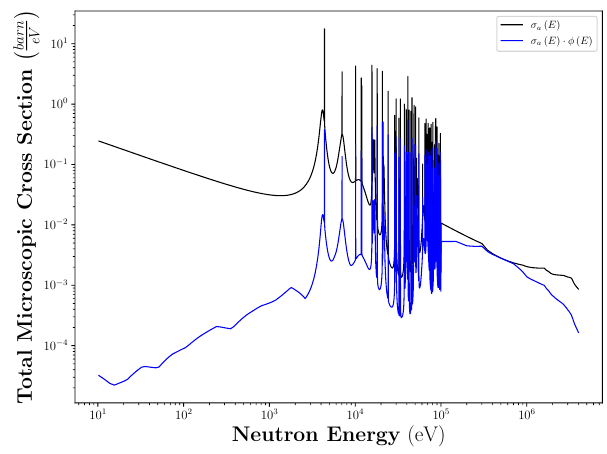
Fig. 3. Microscopic cross section data for 51 Va from ENDF/B-VII.1 (black) and the resultant calculated cross section data (blue) taking into account the SFR neutron flux spectrum [3],